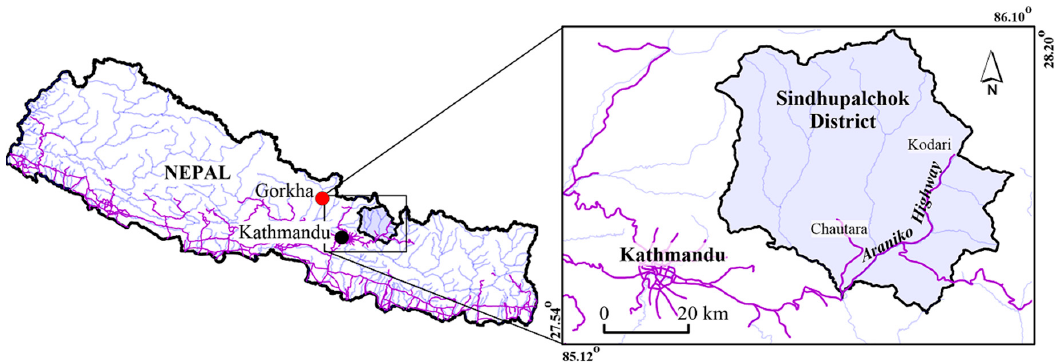
Figure 1. Map showing the location of Sindhupalchowk District.